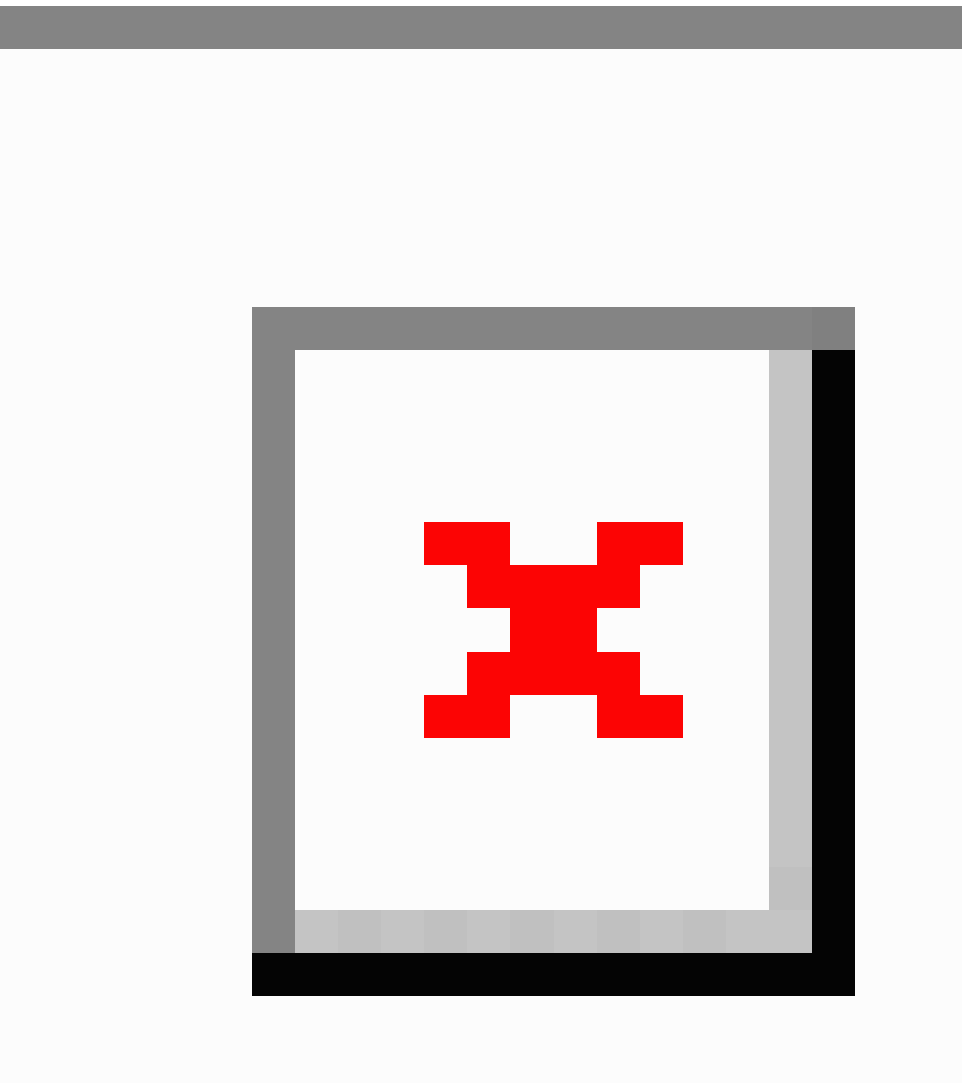
Figure 1. Oral hygiene monitoring system: (a) light-induced fluorescence device and hybrid mobile app; (b) method for monitoring oral hygiene with the naked eye through a mirror; (c) method for monitoring oral hygiene using smartphone; (d) hybrid mobile app that provides time series oral hygiene